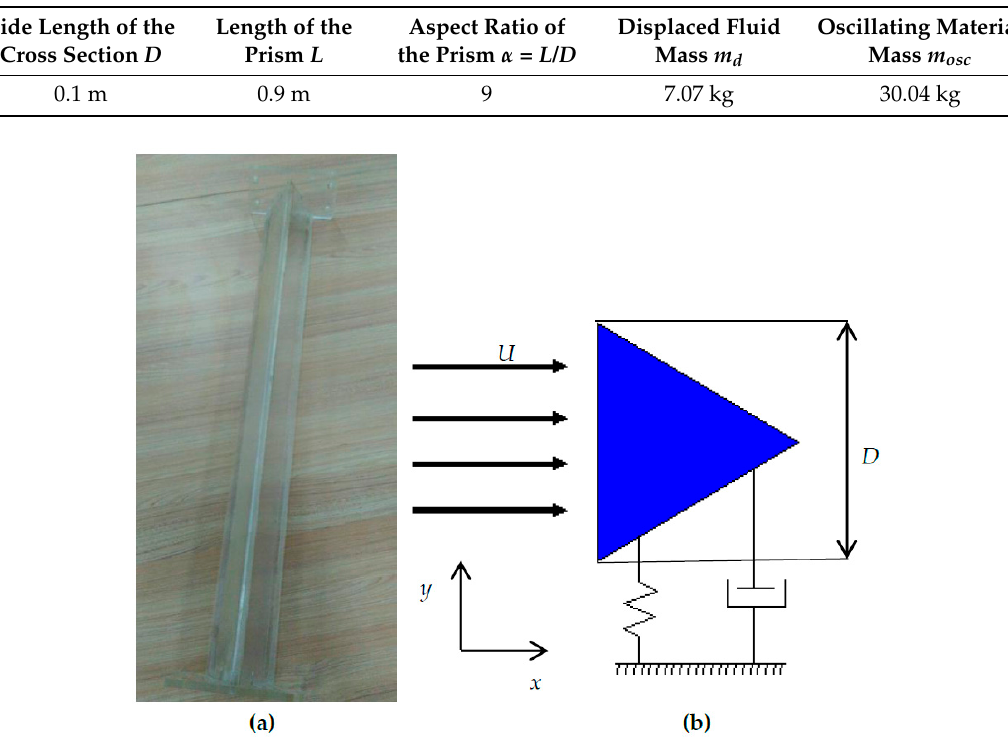
Table 2. Physical model parameters.